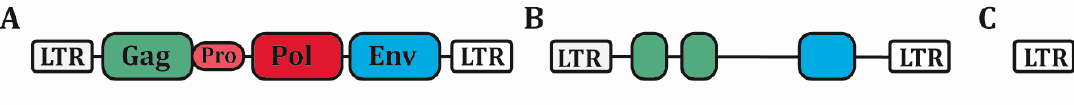
Figure 1. Structure of HERVs. ( A ) The complete proviral sequence of HERVs is composed of four protein-coding sequences (Gag, Pro, Pol and Env) surrounded by two long-terminal repeat (LTR) promoter sequences. ( B ) Most HERVs have acquired many damages on their ORFs, rendering them defective. Still, protein-coding sequences remain in some HERVs. ( C ) The vast majority of HERVs is now composed of solitary LTR. HERVs: Human Endogenous Retroviruses, LTR: Long-terminal Repeat, ORFs: Open-reading frames.